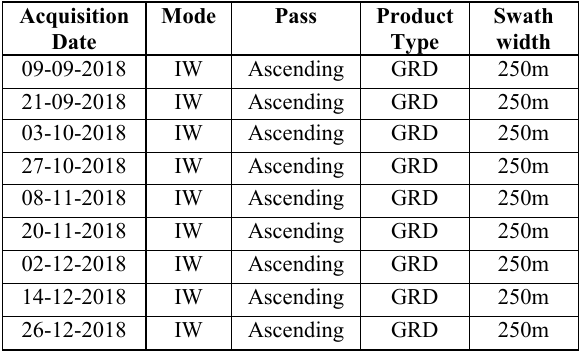
Table 3. Satellite Acquisition Details